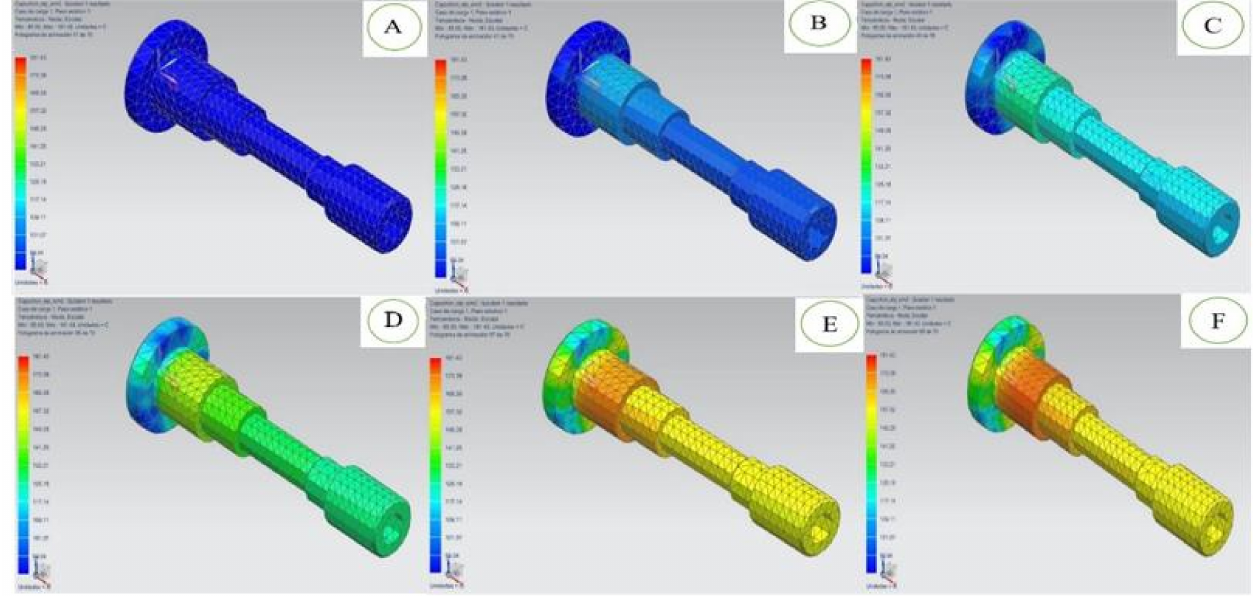
Figure 10. Thermal sequence of Teflon from ( A – F ) related to the time of